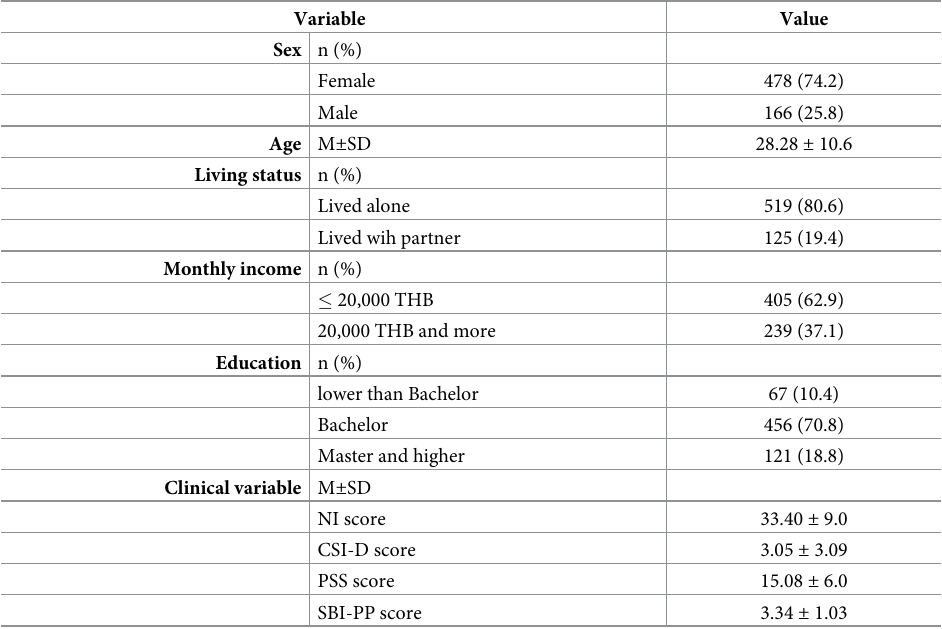
Table 1. Socio–demographic characteristics of the participants (n = 644).